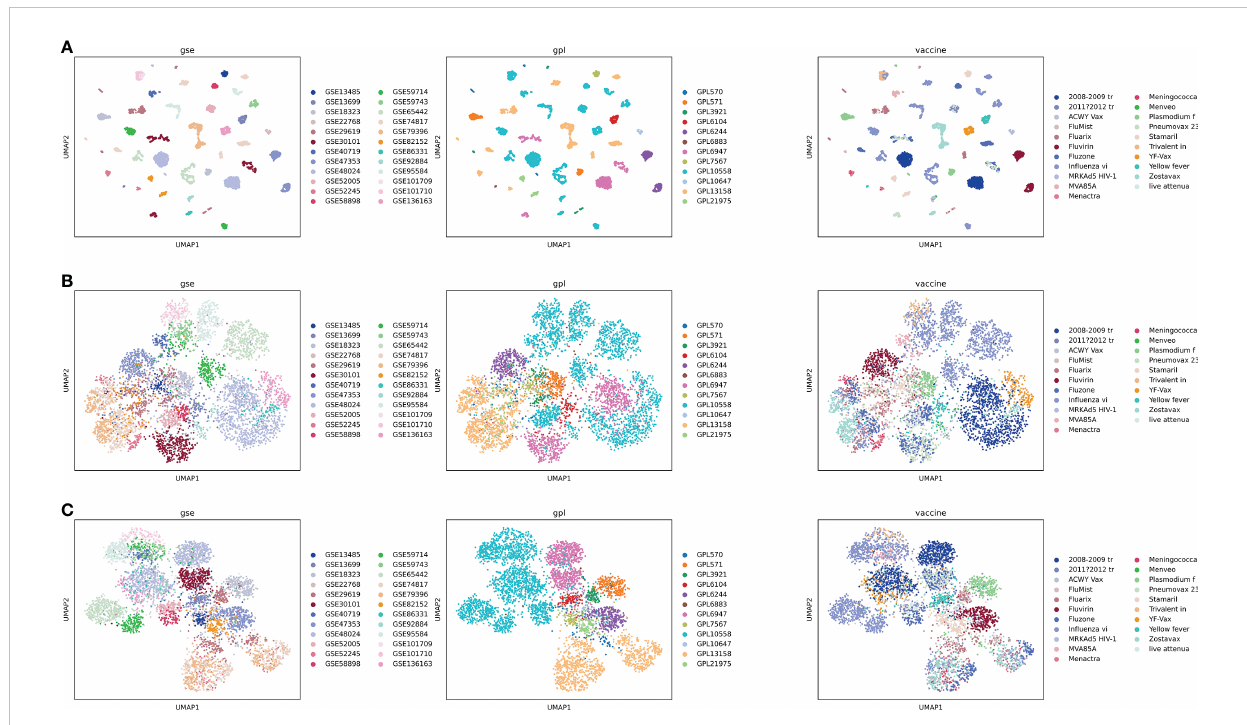
FIGURE 4 UMAP plot of all samples, colored based on vaccines, platforms, and GSEs. GSE-based batch effect is observed clearly (A) , and batch correction was performed using BBKNN for GPL (B) or GSE (C) . Full vaccine names for abbreviations in the legend of the right column: 2008-2009 tr: 2008-2009 trivalent in fl uenza vaccine; 2011?2012 tr: 2011?2012 trivalent inactivated vaccine (A/California/7/09 (H1N1), A/Perth/16/2009 (H3N2), and B/Brisbane/ 60/2008); In fl uenza vi: In fl uenza virus vaccine; Meningococca: Meningococcal Polysaccharide Vaccine, Groups A & C, Menomune A/C; MRKAd5 HIV-1, MRKAd5 HIV-1 gag/pol/nef; Plasmodium f, Plasmodium falciparum vaccine; Pneumovax 23, Pneumovax 23 (USA); Trivalent in, Trivalent inactivated in fl uenza; Yellow fever, Yellow fever 17D vaccine vector; live attenua, live attenuated in fl uenza